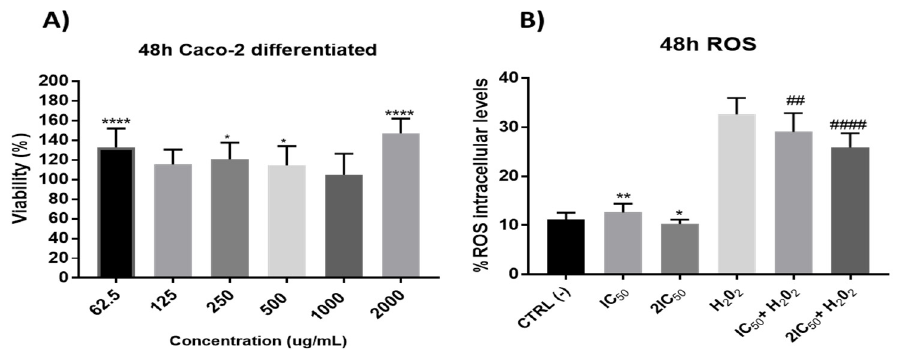
Figure 7. ( A ) Measurement of cell viability in differentiated Caco-2 cells after incubation with onion extracts at 62.5, 125, 250, 500, 1000 and 2000 µ g/mL for 48 h. * p < 0.5; **** p < 0.0001. ( B ). Measure- ments of ROS levels on differentiated Caco-2 cells in absence or presence of H 2 O 2 (80 mM, 20 min) after 48 h of incubation with onion extract at IC 50 (1000 µg/mL) and 2xIC 50 (2000 µg/mL). ## p < 0.01; #### p < 0.0001 vs. H 2 O 2 .; * p < 0.05; ** p < 0.01 vs. CTRL.